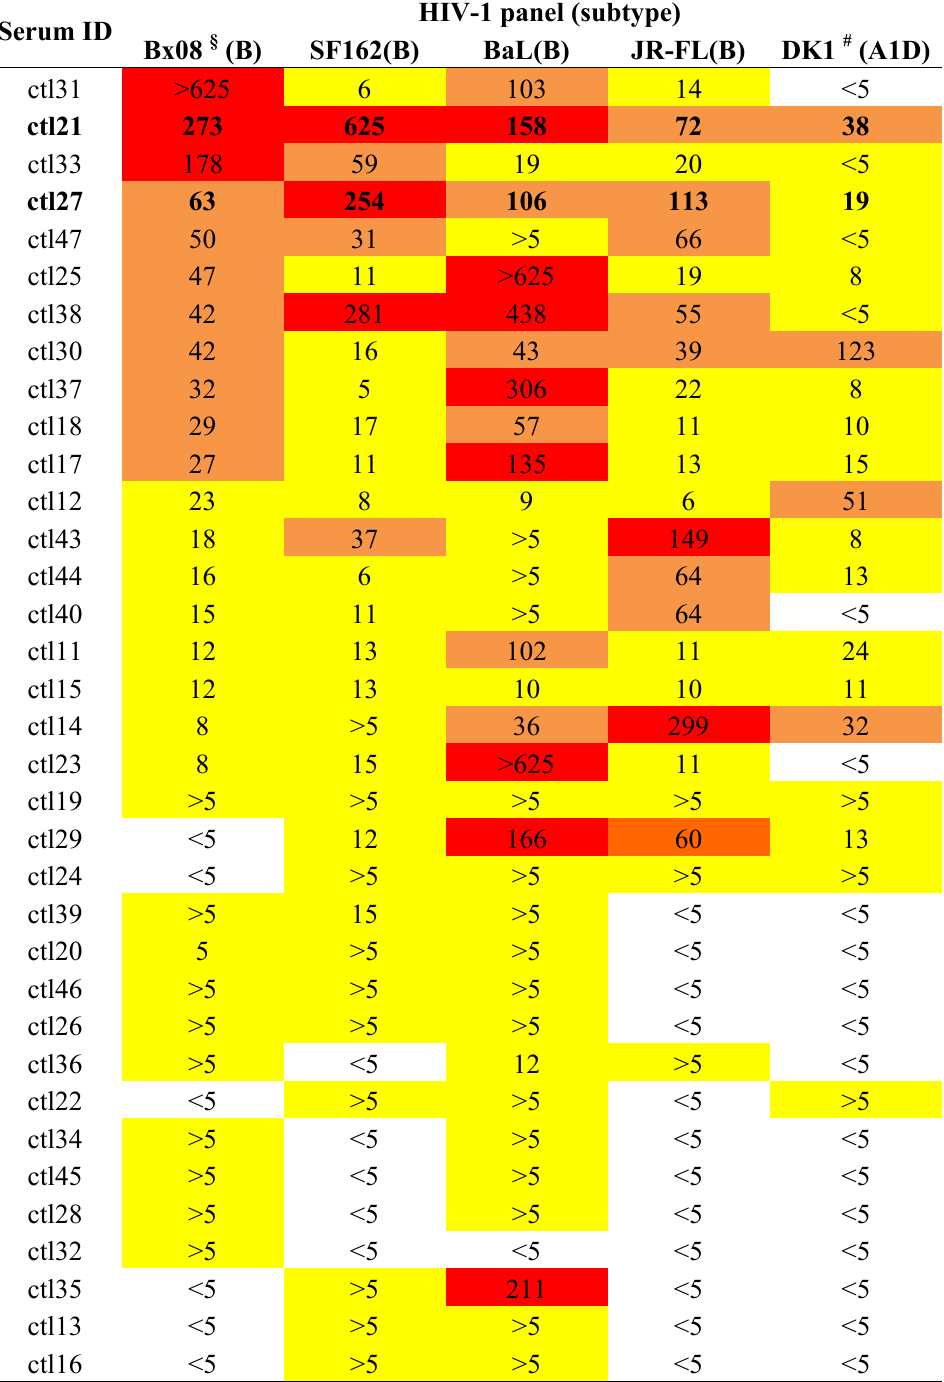
Table 1. HIV-1-specific neutralizing activity in serum from infected individuals (n = 35). Given reciprocal titers correspond to 1/dilution of serum giving 80% inhibitory concentration (IC80) in the PBMC neutralization assay. Color coding: IC80 < 5: no color, 5–25: yellow, 25–125: orange or 125–625: